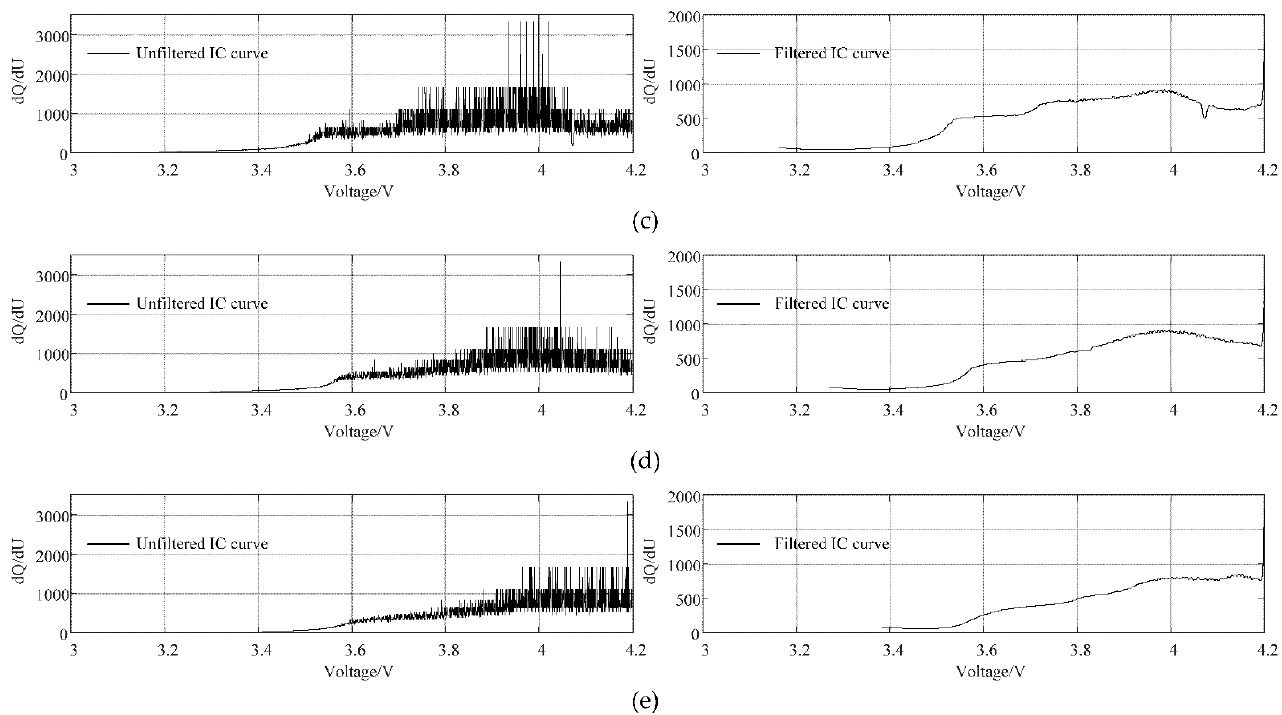
Figure 3. IC curve under different SOH: ( a ) SOH = 100%, ( b ) SOH = 95%, ( c ) SOH = 90%, ( d ) SOH = 85%, ( e ) SOH = 80%.